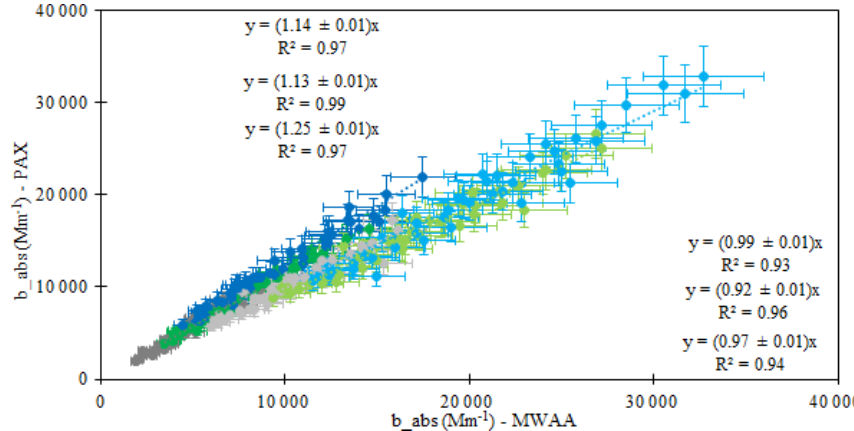
Figure 11. Correlation study between the absorption coefficient measured by PAX and MWAA. The colours of the dots identify the wave- length of the analysis, where grey refers to 870nm, green to 532nm, and blue to 405nm. Events with cyclone, where light grey refers to 870nm, light green to 532nm, and light blue to 405nm, and without cyclone are